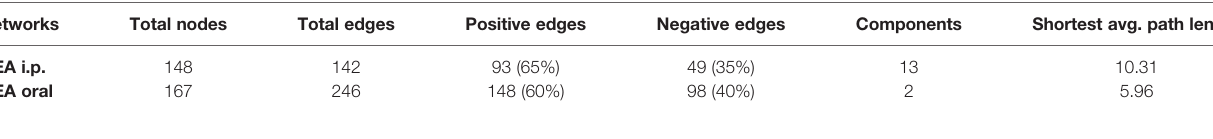
TABLE 3 | Properties of the networks reported in Figure 7